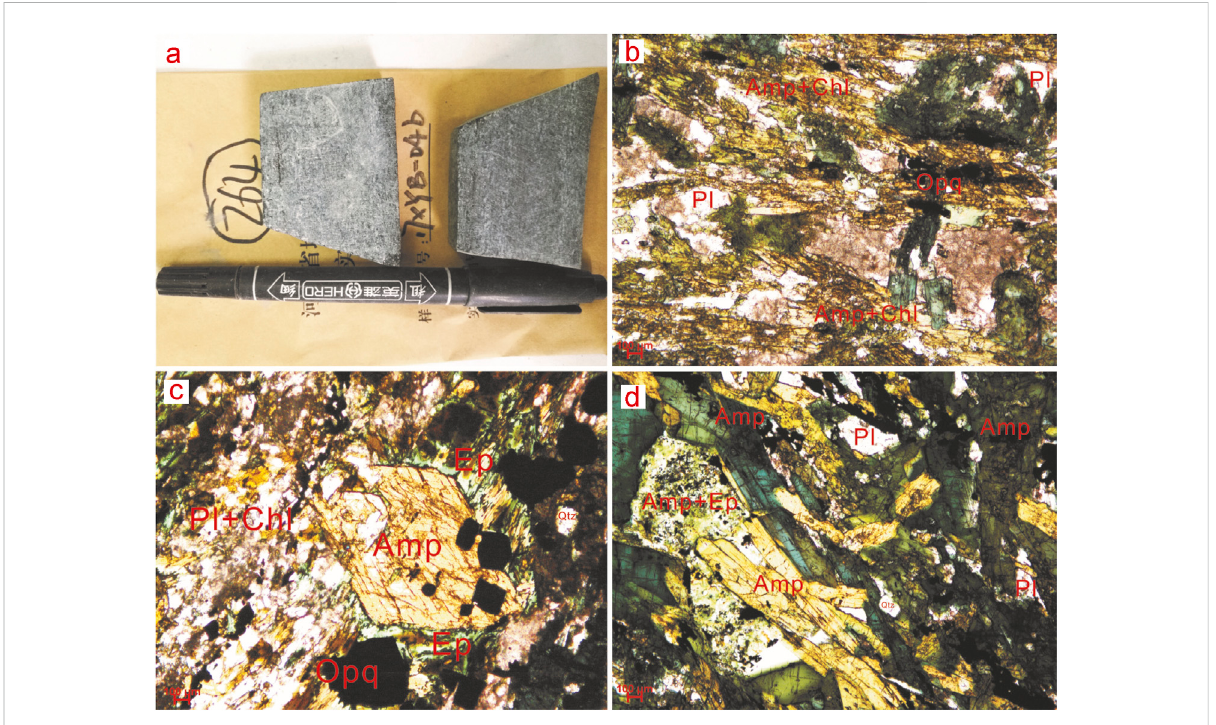
FIGURE 4 Photographs of typical amphibolite in the Xunyangba area (crossed-polarized light). (A) is the hand specimen of amphibolite. (B – D) are the microphotographs of the amphibolite (perpendicular-polarized light) (Note: Mineral abbreviations that appear in this article are as follows: Amp = amphibolite, Bt = biotite, Cal = calcite, Chl = chlorite, Ep = epidote, Grt = garnet, Ms = muscovite, Pl = plagioclase, Qz = quartz, and Opq = opaque